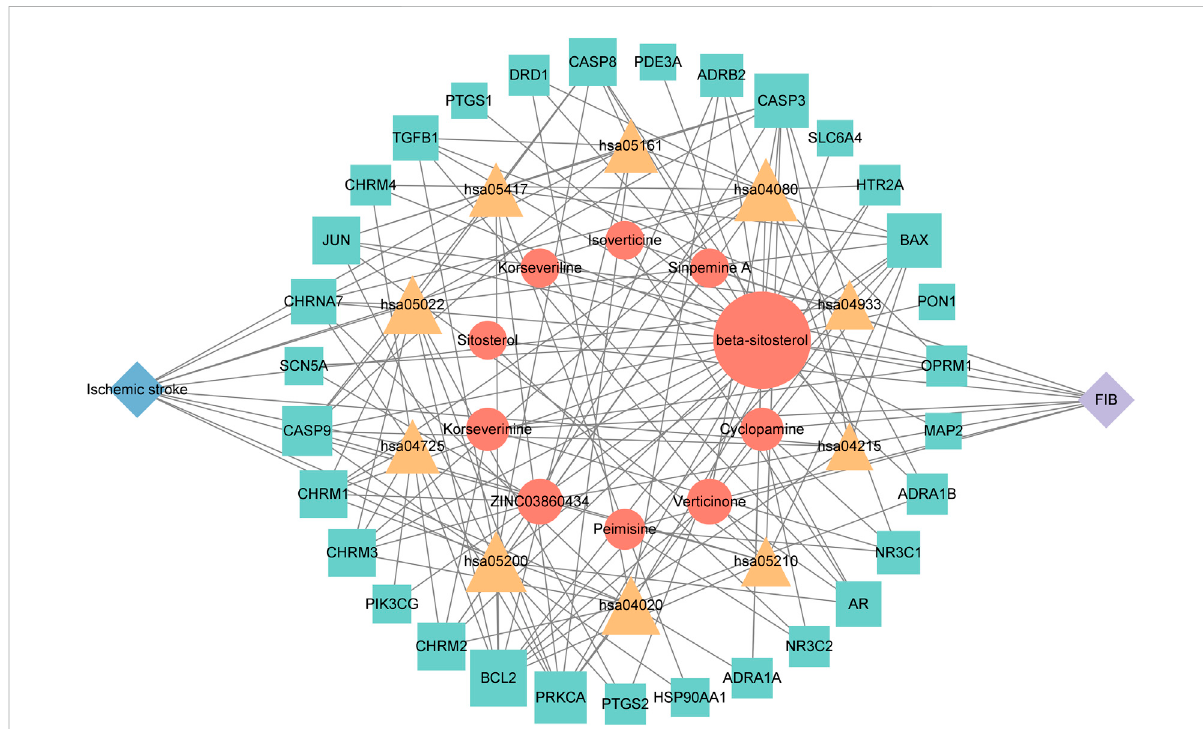
FIGURE 7 Theherb-chemicalcomposition-coretarget-disease-keypathwaymultilevelnetwork.Pathways,compoundsandtargetswererepresentedby yellow triangular-, orangecircular-and green square nodes,respectively. The greater theDegreevalueofanode was, thelarger thesize wereinthe